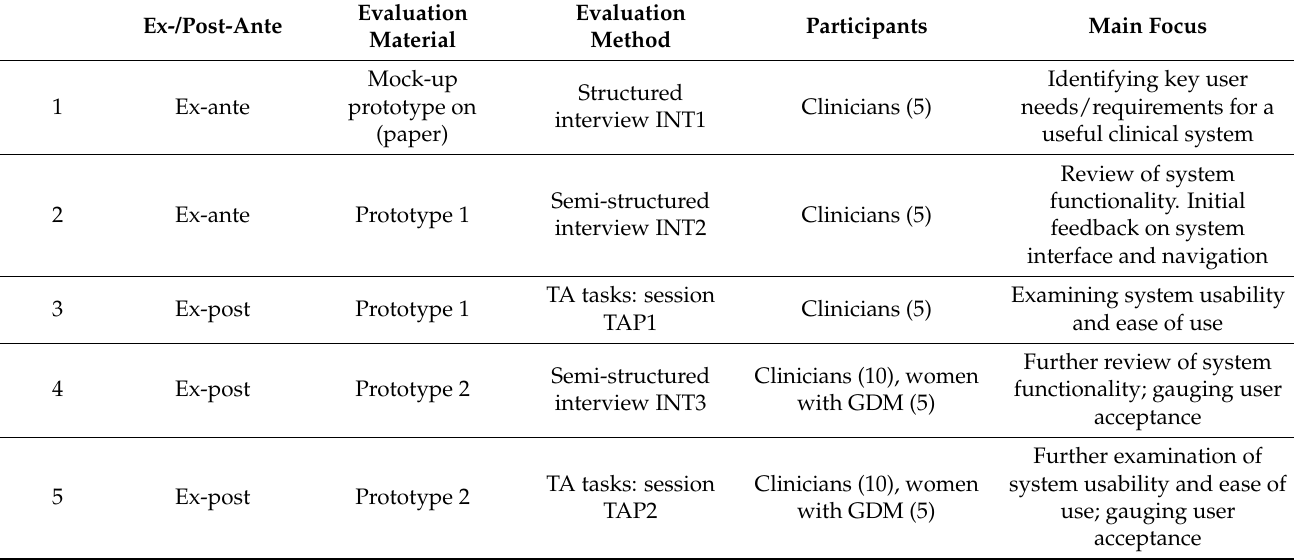
Table 2. System evaluation